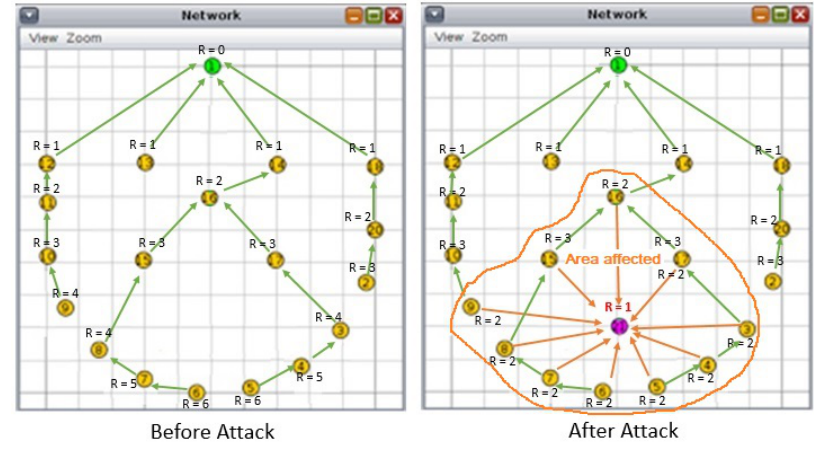
Figure 4. Rank attack.